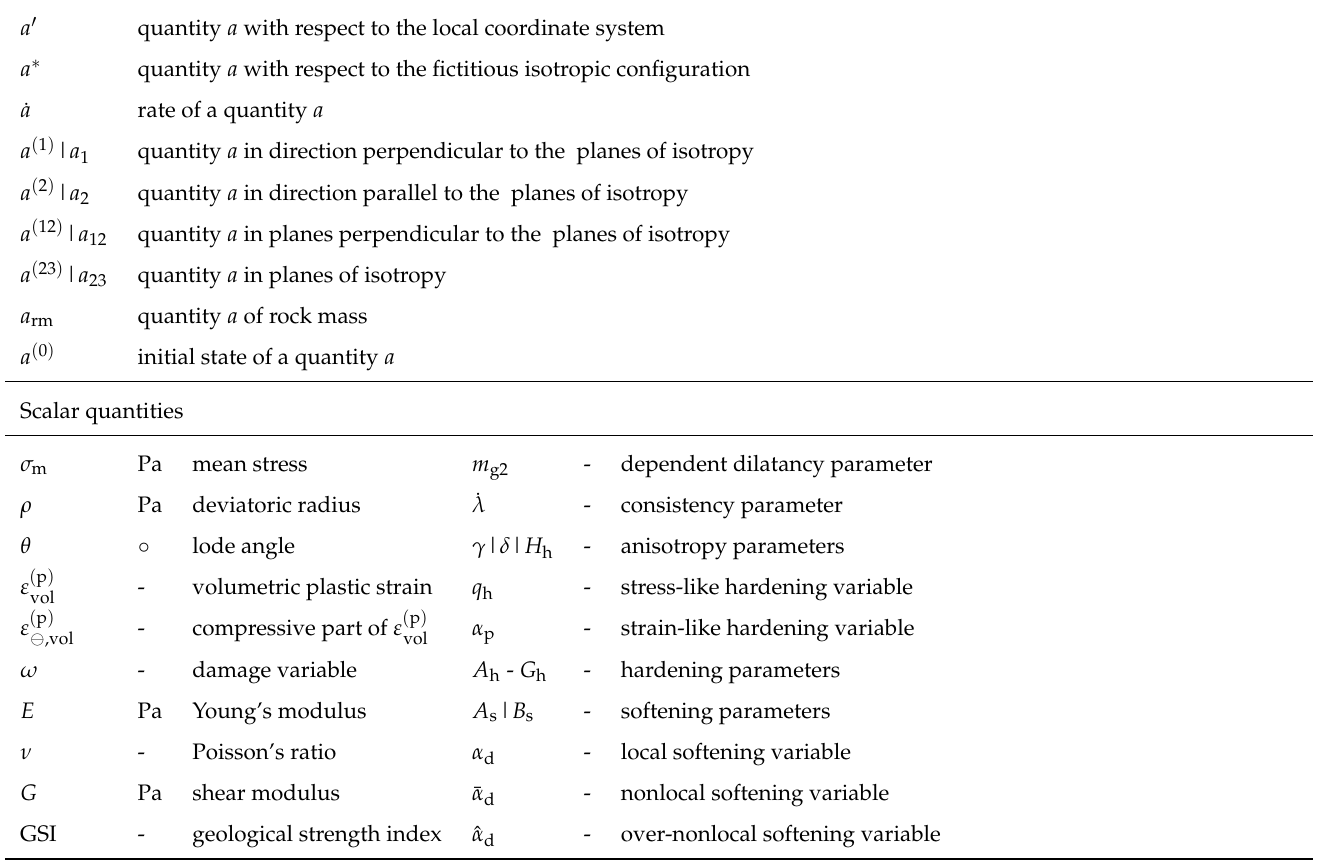
Table A1. List of